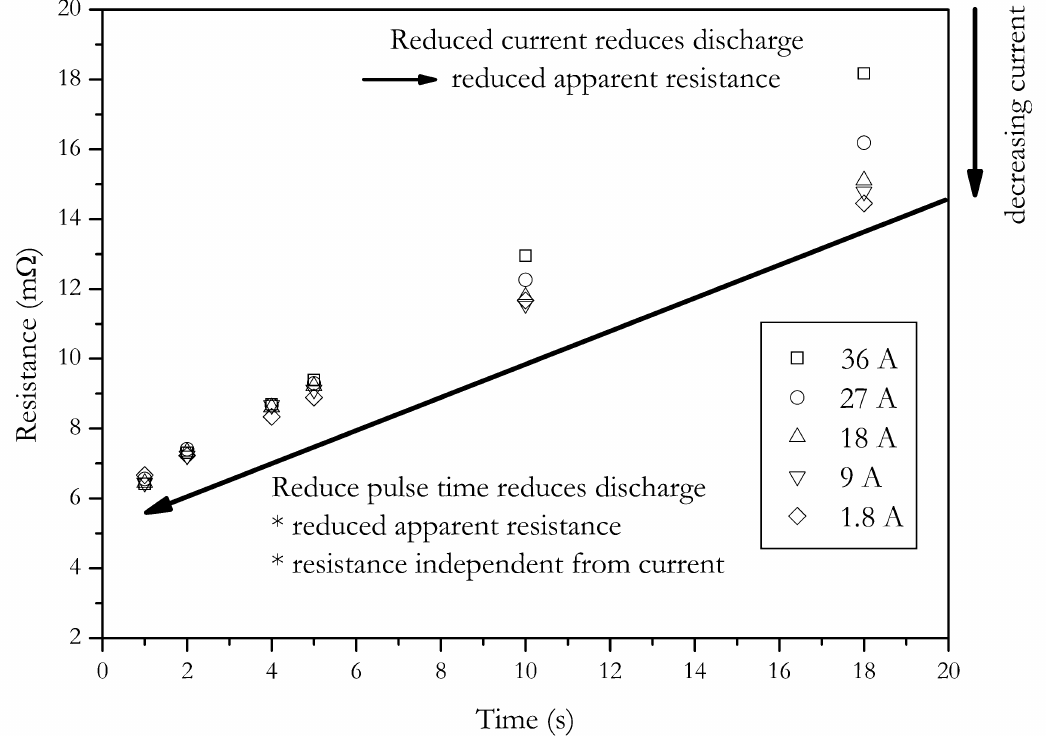
Figure 4. Dependence of calculated internal resistance on pulse duration and pulse